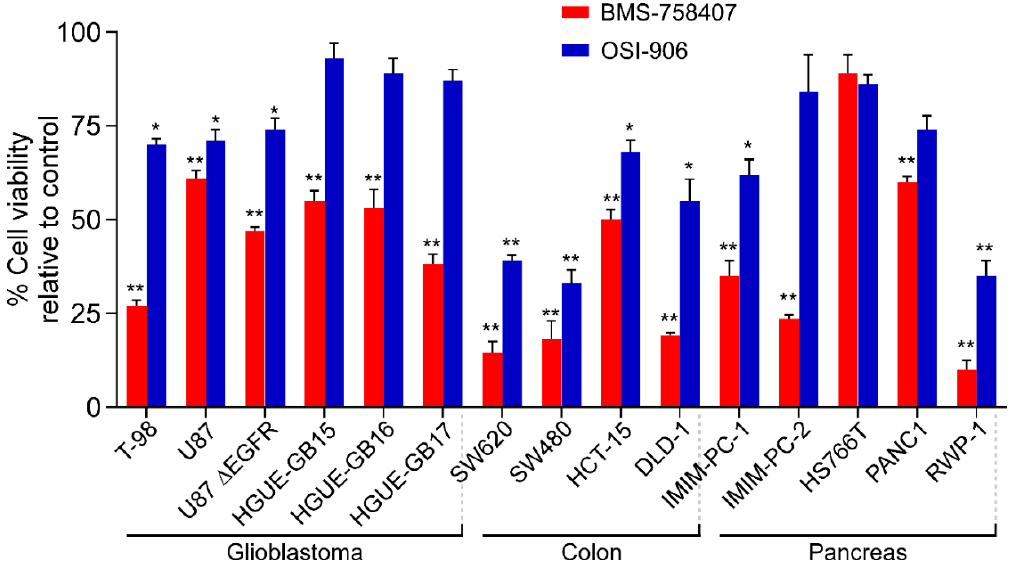
Figure 2. BMS-754807 and OSI-906 effect on cell viability in glioblastoma, colon and pancreatic cancer cell lines. The indicated cell lines were treated with 10 µM BMS-754807 or OSI-906 for 72 h, and cell proliferation was evaluated by MTT assays. Data represent the mean ± SEM ( n ≥ 6) of viable cell percentage in the presence of 10 µM BMS or OSI compounds, as compared to untreated cells taken as 100%. *, p < 0.05; **, p < 0.01.